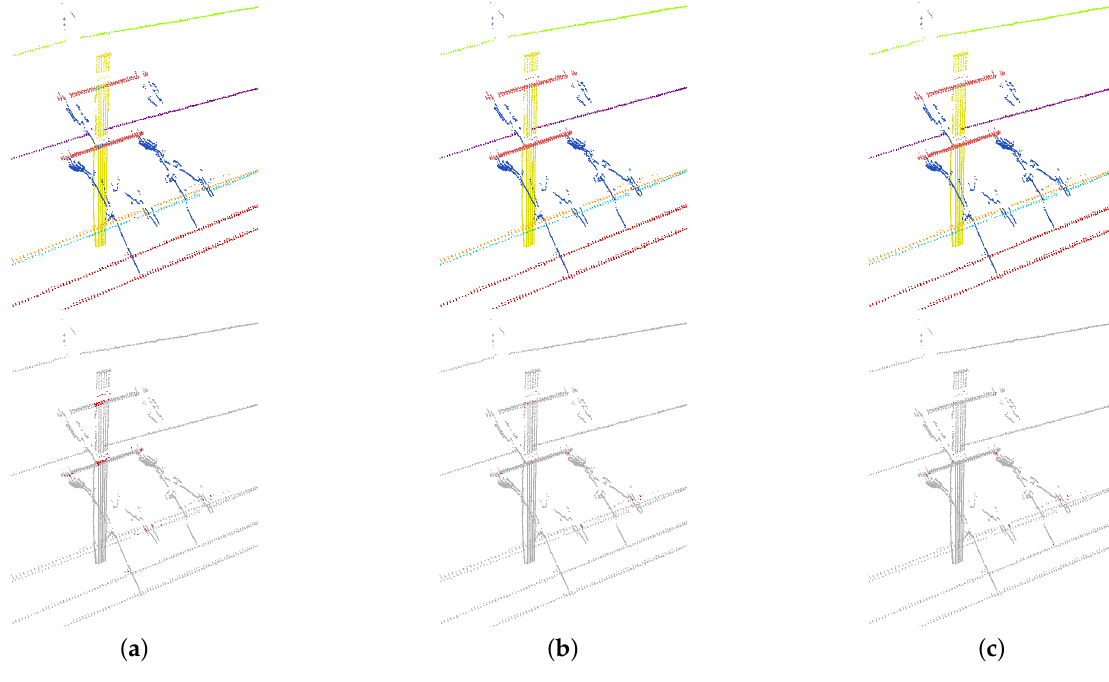
Figure 11. Segmentation results of a scene with spreaders: ( a ) non-feature fusion mode; ( b ) unidirectional mode; and ( c ) bidirectional mode. Table 8. Comparison of the results with multi-scale feature extraction ( ε = 0.5,2,7) in the non-feature fusion mode, the unidirectional mode, and the bidirectional